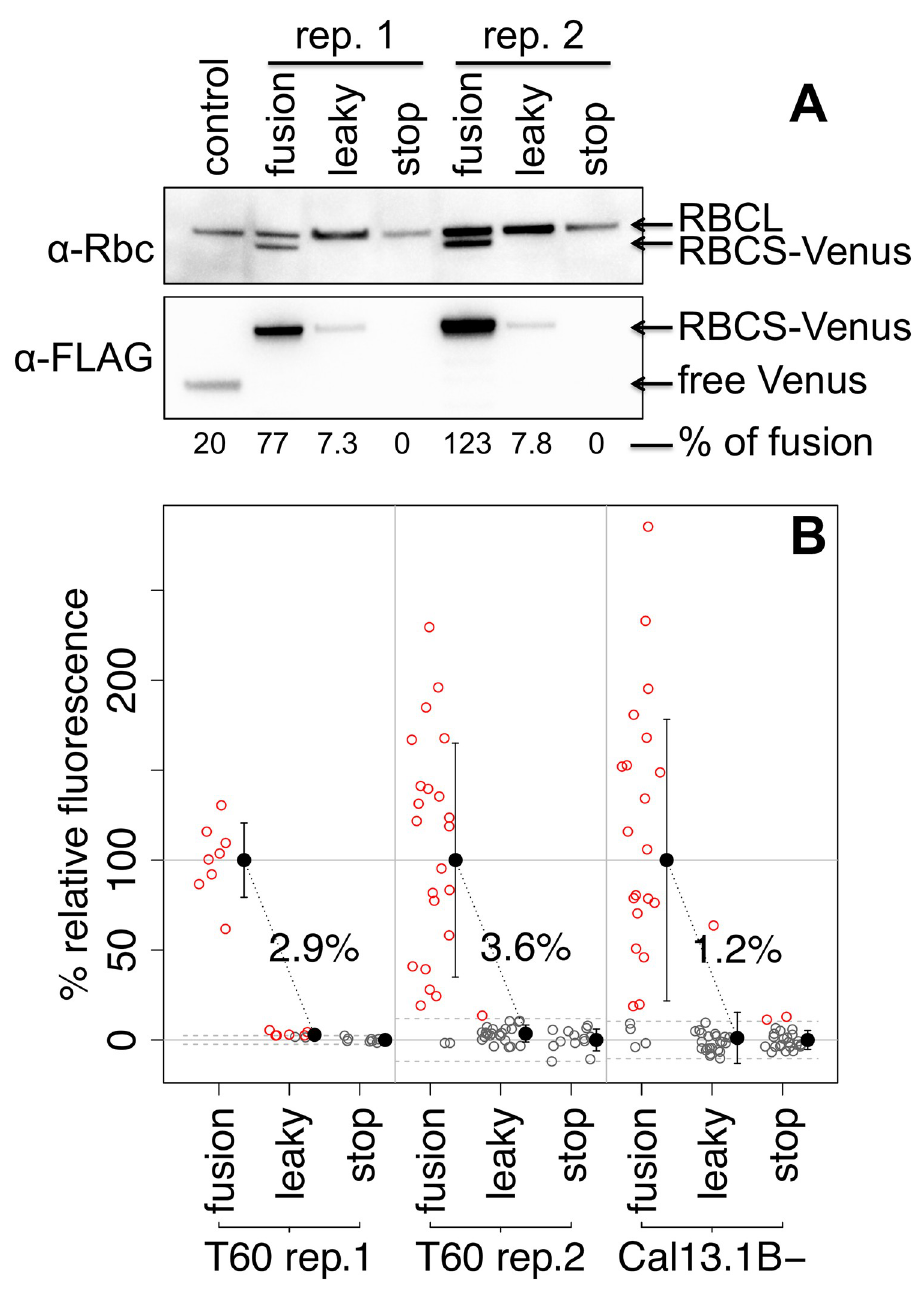
Fig 3. The leaky stop-codon has read-through rates of ~2.5% ( ± 0.7). (A) Whole cell protein extracts from transformants of indicated constructs in a RBCS-knockout strain (T60), with loading normalized to 2 μ g chlorophyll per lane, were immunolabelled with either a polyclonal antibody against Rubisco ( α -Rbc) that recognizes both large (RBCL) and small (RBCS) subunits, or an antibody that recognizes the FLAG-tag ( α -FLAG) at the Venus C-terminus. A ‘ribosome reinitiation’ construct transformant was used for the ‘control’ lane as this strain contains free Venus and no RBCS. Blots were cropped for clarity, raw images are available in S1 Raw images. Bands of the α -FLAG blot were quantified and relative amounts indicated in percent, with 100% corresponding to the average across the two ‘fusion’ replicates. (B) For each biological replicate, Venus fluorescence of a randomly drawn sample of transformants selected for paromomycin resistance was quantified and plotted after normalization setting the ‘stop’ construct average as 0 and the ‘fusion’ construct population average as 100%. Empty circles represent individual transformants, drawn in red if the value exceeds the 95% confidence interval for ‘stop’ construct transformants indicated by dashed lines, or in grey if not. Population averages and standard deviation are plotted in black to the right of each distribution. Population averages for the ‘leaky’ construct are written above the point cloud. All numeric data is available in S1 Data.